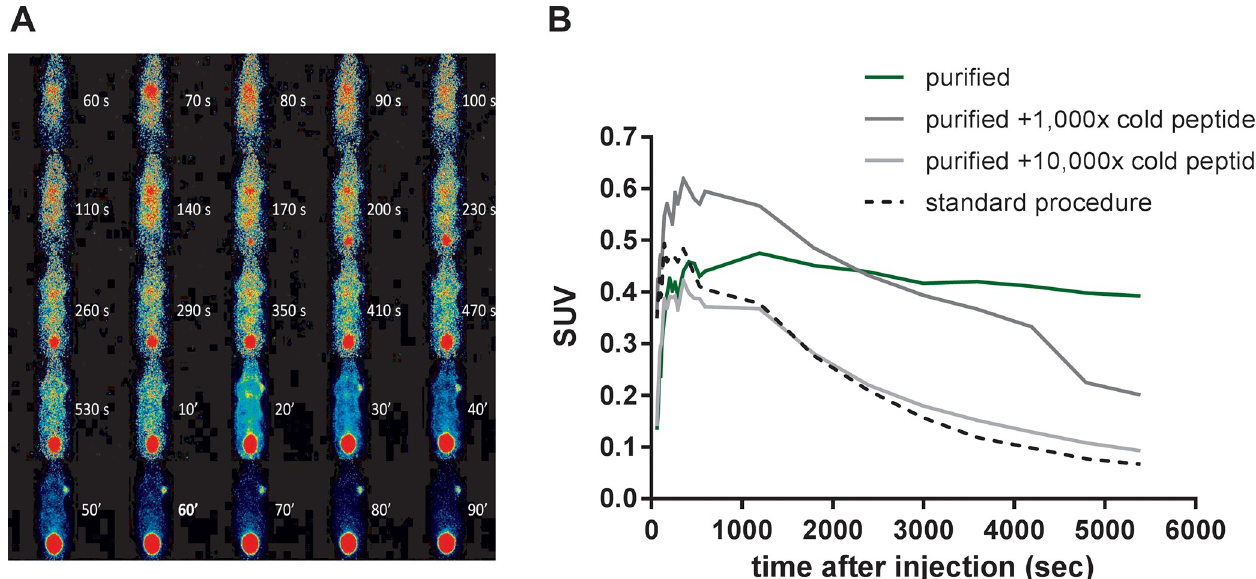
Fig 6. A Short-interval reconstruction from dynamic PET data of a mouse bearing a B16/F1 tumor on the right shoulder after tail vein injection of 5 MBq purified 68 Ga-NAPamide. Injected peptide amounts: 500 pmol (unpurified and 10,000-fold excess), 50 pmol (1,000-fold excess) and 0.05 pmol (purified). B Time-activity relationships of 68 Ga-DOTA-NAPamide B16/F1 tumor accumulation derived from dynamic PET data obtained after injection of four different tracer formulations (n = 1).